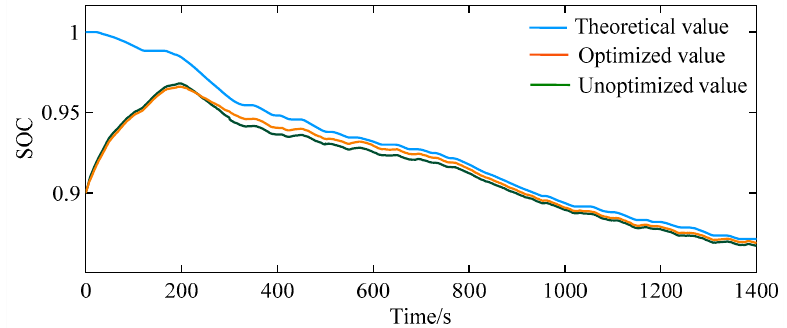
Figure 16. The comparison of the SOC estimation between the simulated value and the theoretical value.